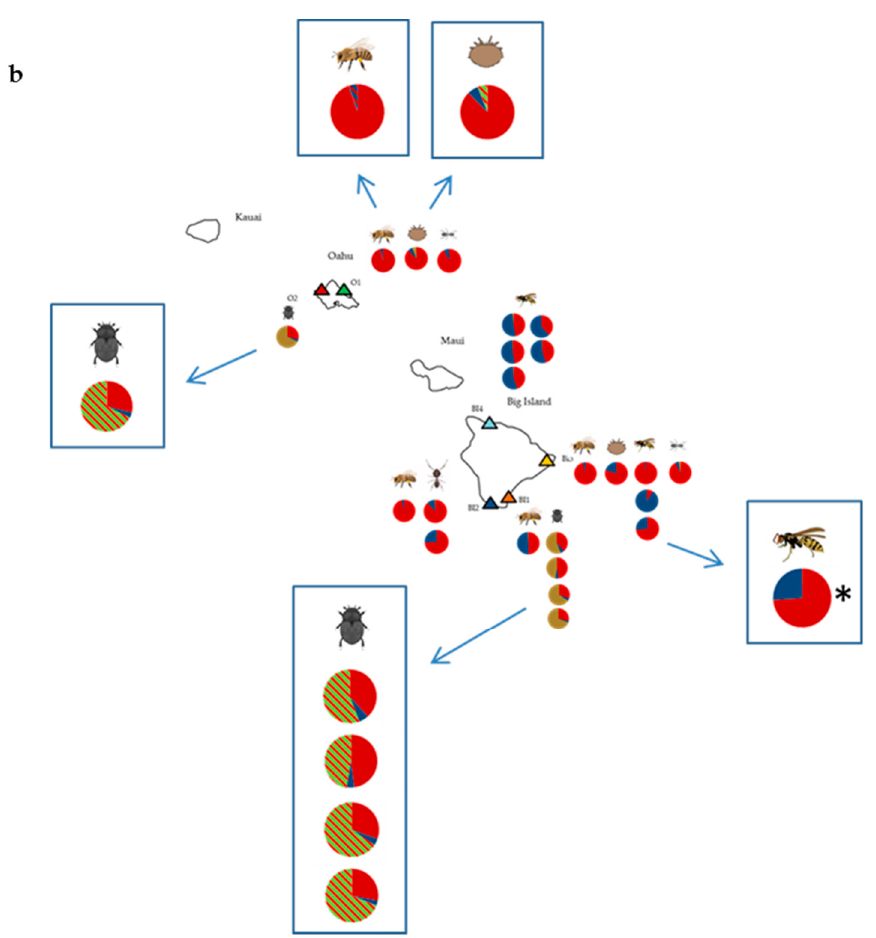
Figure 1. Proportions of deformed wing virus (DWV)-like reads in individual samples from each species mapping to DWV type A (red), type B (blue), and type C (green) along with the site from which they were collected. ( a ) Results using BLAST top hit analysis only (read numbers provided in Table S4); ( b ) where results were amended after considering additional Geneious mapping analysis (Figure S1). Green and red stripes represent that DWV-A / DWV-C recombinants were present (rather that true full-length DWV-C,), red and blue stripes denote a DWV-A / DWV-B recombinant (no full-length DWV-B), and the asterisk represents an additional sample identified as containing recombinant(s). Results for all other samples remain unchanged. Insect images are from BioRender [23,31].